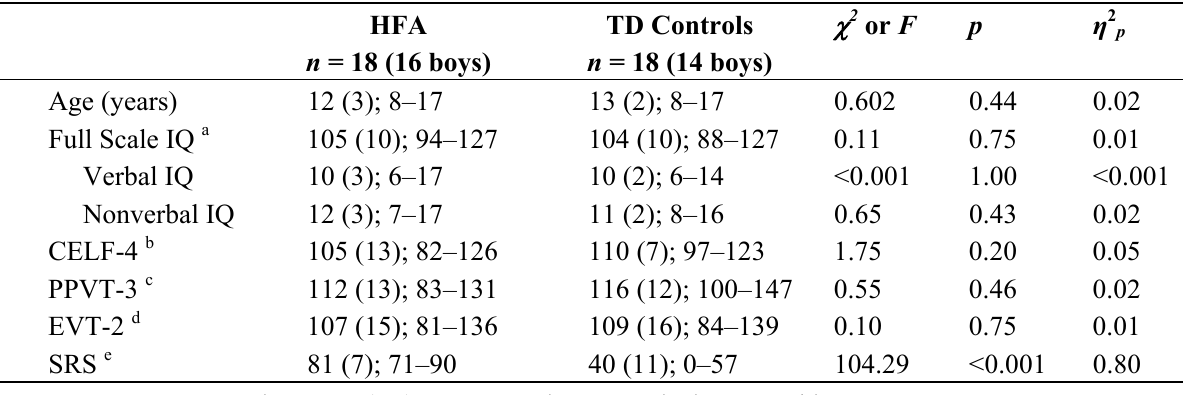
Table 4. Participant demographics and standardized cognitive